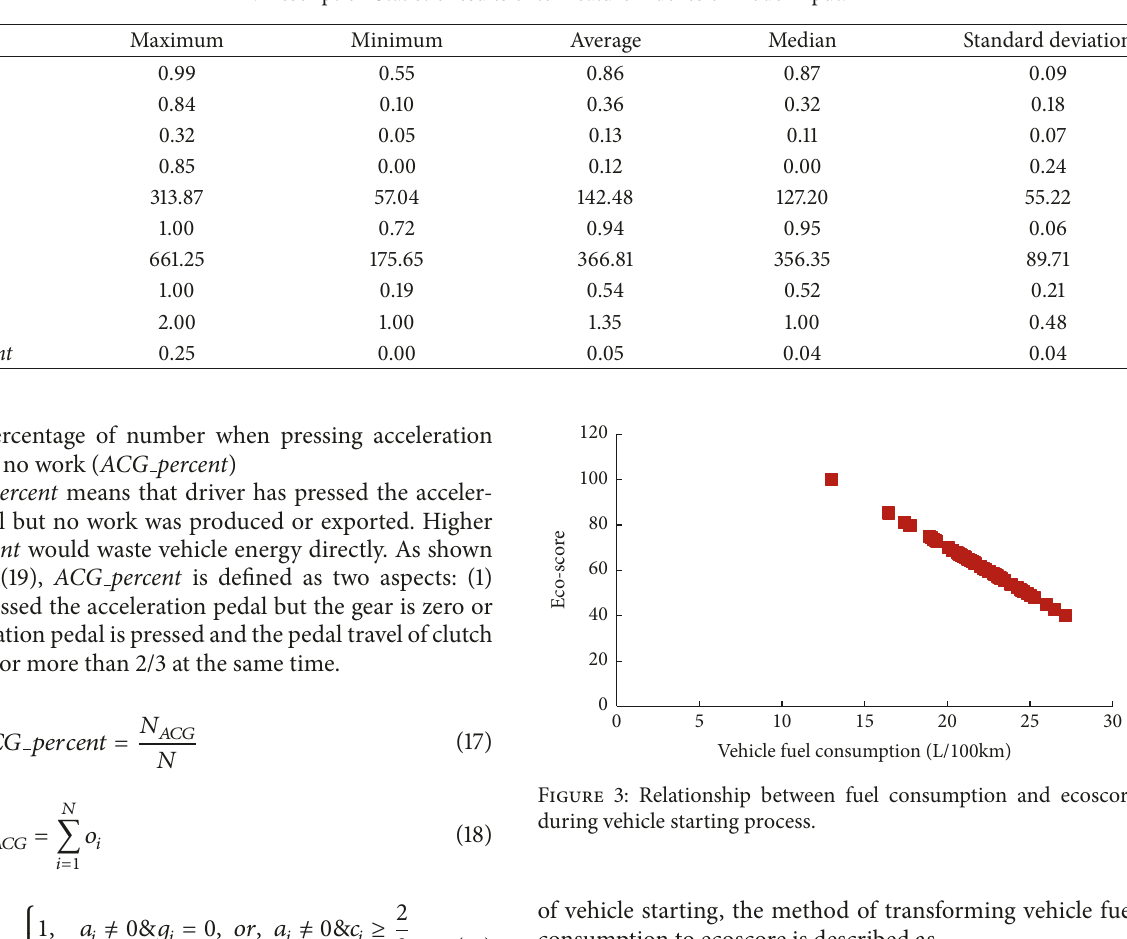
Table 1: Description Statistic results of ten feature indexes of model input.